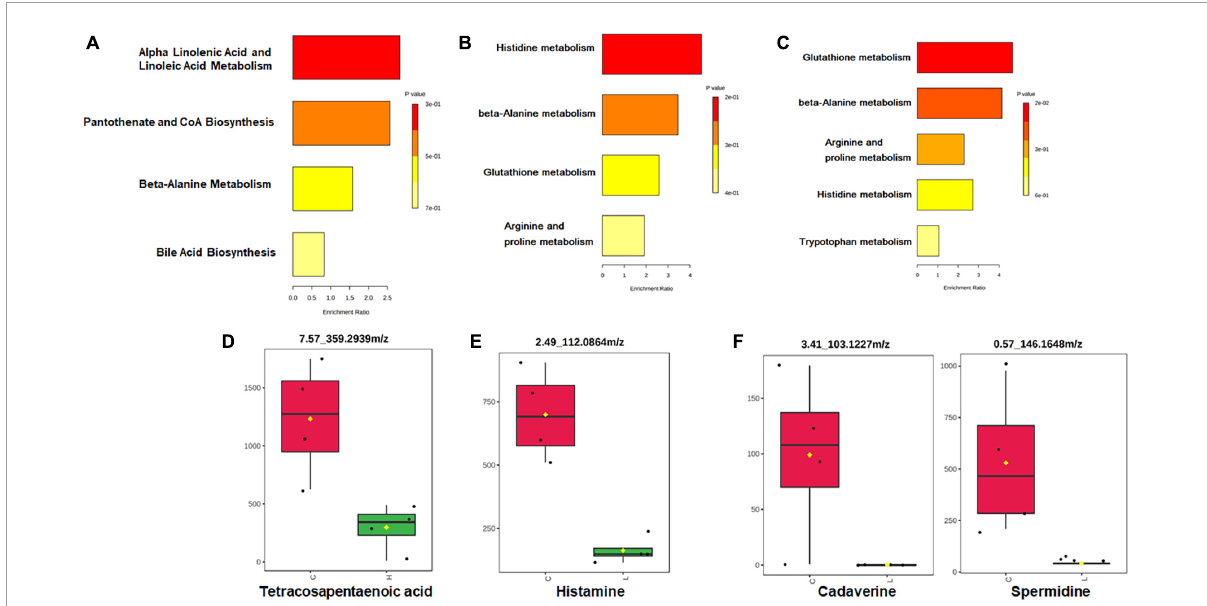
FIGURE6 Pathway enrichment and statistical significance of the unique or significantly changed metabolites in CRC (A) , inflammation (B) , and health (C) . Represented metabolites engaged in the significantly changed metabolic pathways of CRC (D) and inflammation (E) . (F) Represented unique metabolites detected in health